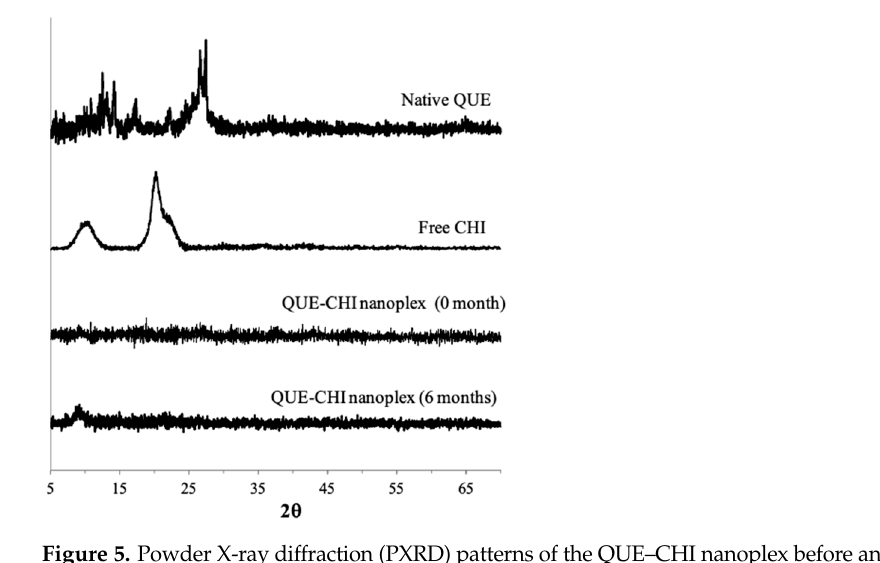
Figure 5. Powder X-ray diffraction (PXRD) patterns of the QUE–CHI nanoplex before and after